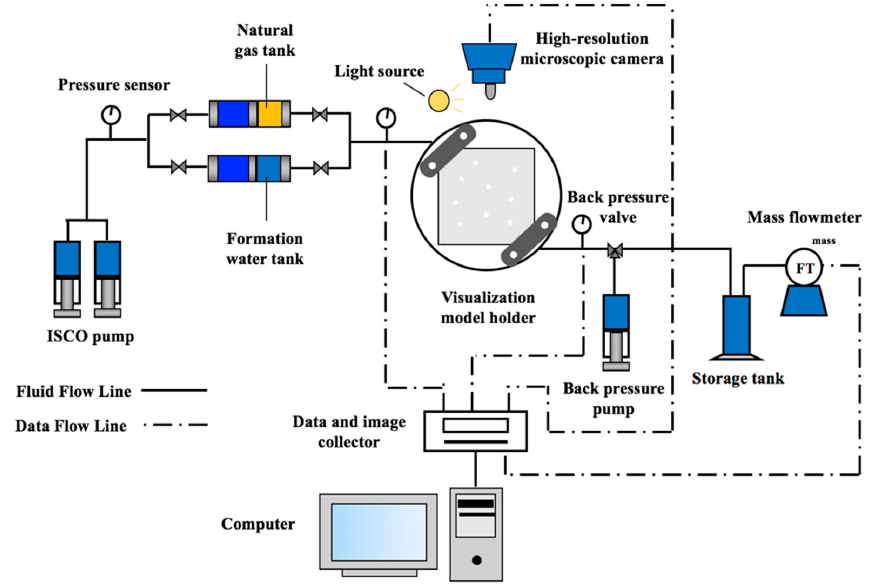
Figure 7. Schematic diagram of the two-dimensional visual simulation experiment.